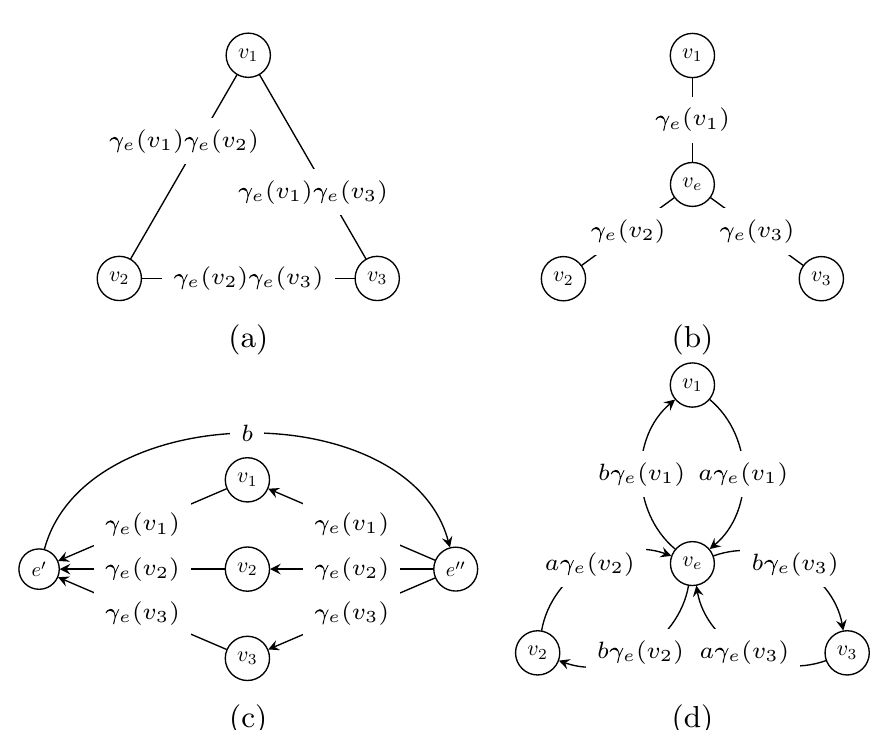
Fig. 1 The illustration of ( a ) a clique gadget, ( b ) a star gadget, ( c ) a symmetric EDVWs-based gadget, and ( d ) an asymmetric EDVWs-based gadget, for a hyperedge e = { v 1 , v 2 , v 3